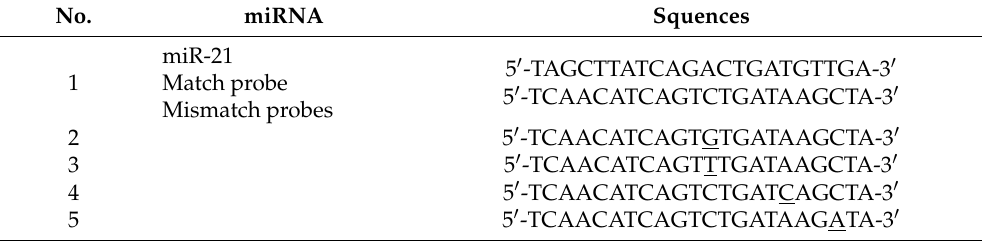
Table 2. Matching and mismatching sequences for osteosarcoma miR-21.